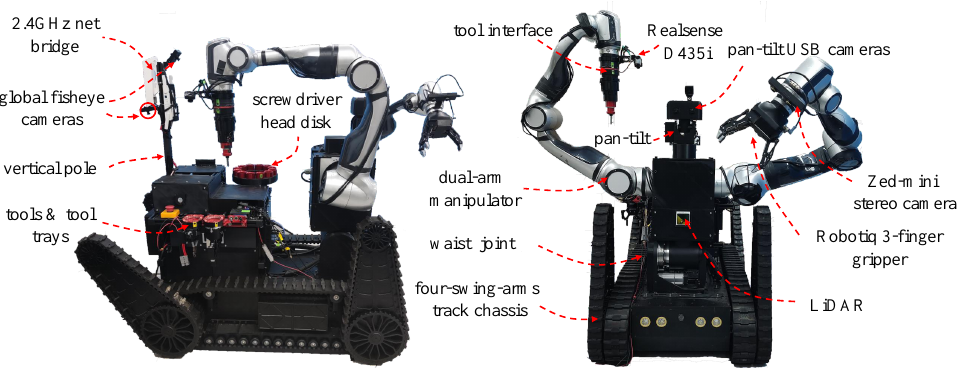
Figure 1. The overall appearance of the proposed robot. The FC-EODR adopts a four-swing arm crawler chassis, where two main crawlers drive platform, and the four swing crawlers rotate to realize a vertical movement of the chassis to complete obstacle crossing smoothly. The chassis structure and its power distribution are shown in Figure 2. The main body of the four-swing arm crawler chassis is an aluminum casing. The torque output shaft is placed at the symmetrical front and rear positions of the chassis. The output shaft has a coaxial dual-output design. The external shaft transfers power to the main track, which drives the driven wheel to synchronize the speed of the main track and the swing arm track on one side. The direction of the car body is adjusted through the differential speed. The left and right swing arms are fixed together through the internal shaft, resulting in the angle of the two front or two rear swing arms to be the same. The drive motor, reducer, driver, and microcontroller are placed inside the casing. To balance the center of gravity of a vehicle, the motors are placed symmetrically on the front and rear sides. The main track reducer and the swing arm track reducer use the planetary reducer, and bevel gears are employed to turn the power to 90° for output. Between the main track and the casing, tensioner wheels and road wheels are installed.